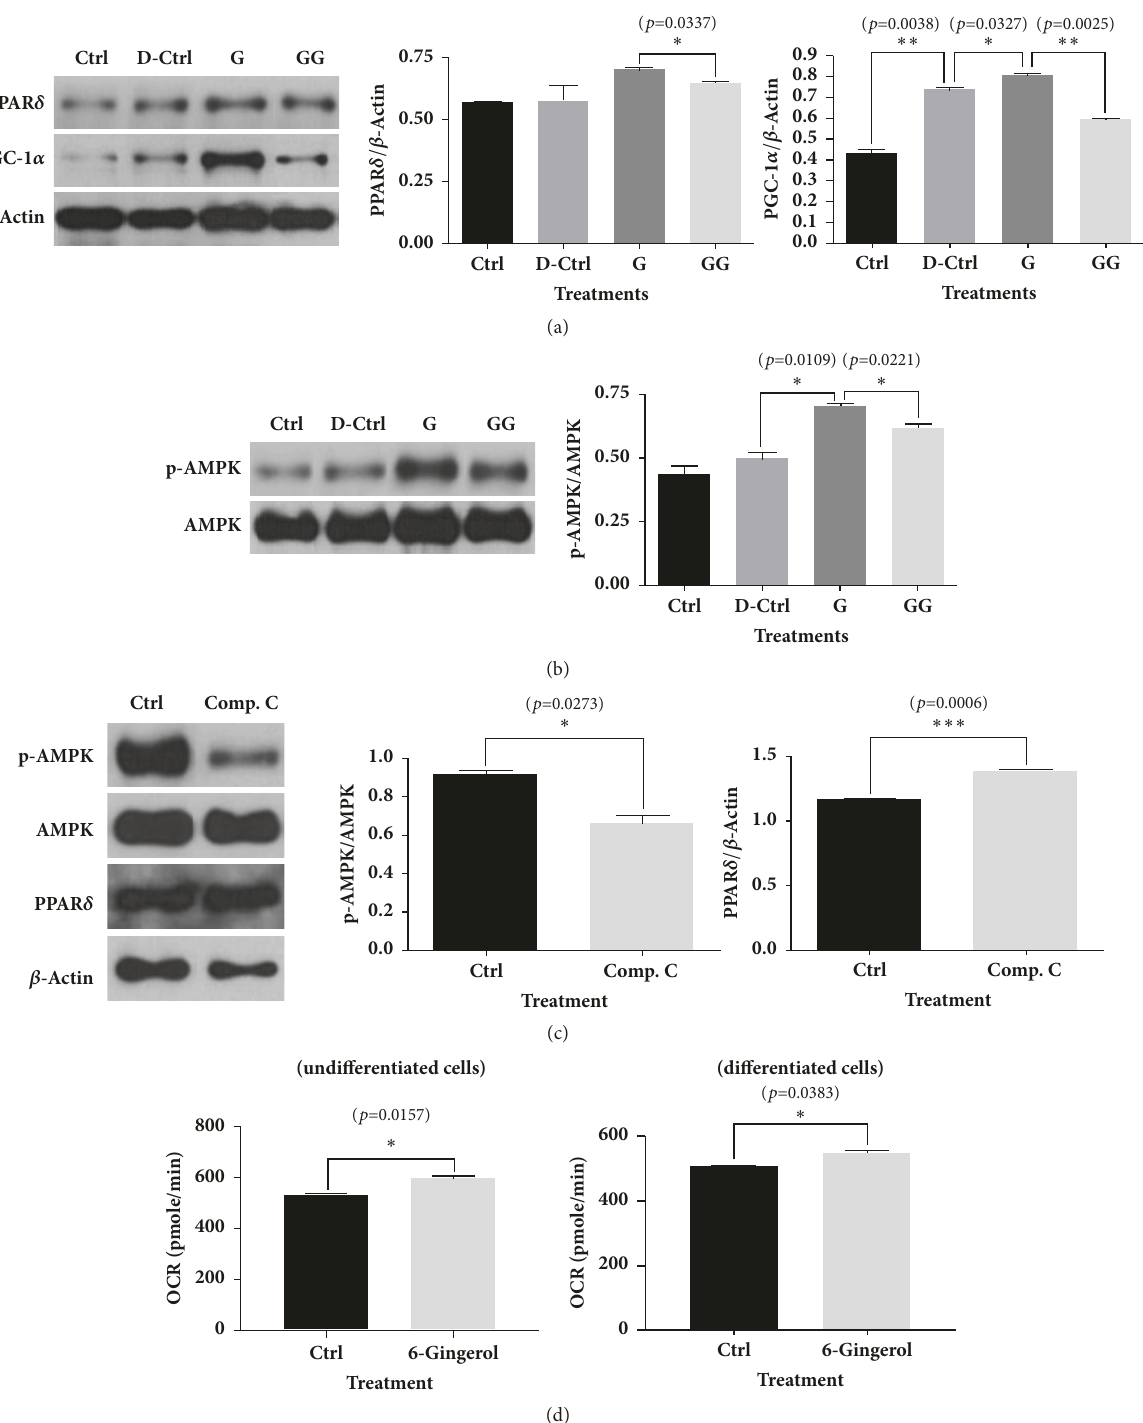
Figure 7: W estern b l o t anal y ses fo r PPAR 𝛿 , AMP K, PGC- 1 𝛼 in d i ff erentiate d 3 T 3 - L1 cells treate d w it h 6 - g in g er o l an d GS K0660; w estern b l o t anal y ses fo r PPAR 𝛿 an d AMP K in u n d i ff erentiate d 3 T 3 - L1 cells treate d w it h c o m pou n d C ; t h e estimati o n of OCRs in u n d i ff erentiate d an d d i ff erentiate d 3 T 3 - L1 ce lls. (a, b) 6-Gingerol increased the levels for PPAR 𝛿 , AMPK, and PGC-1 𝛼 compared